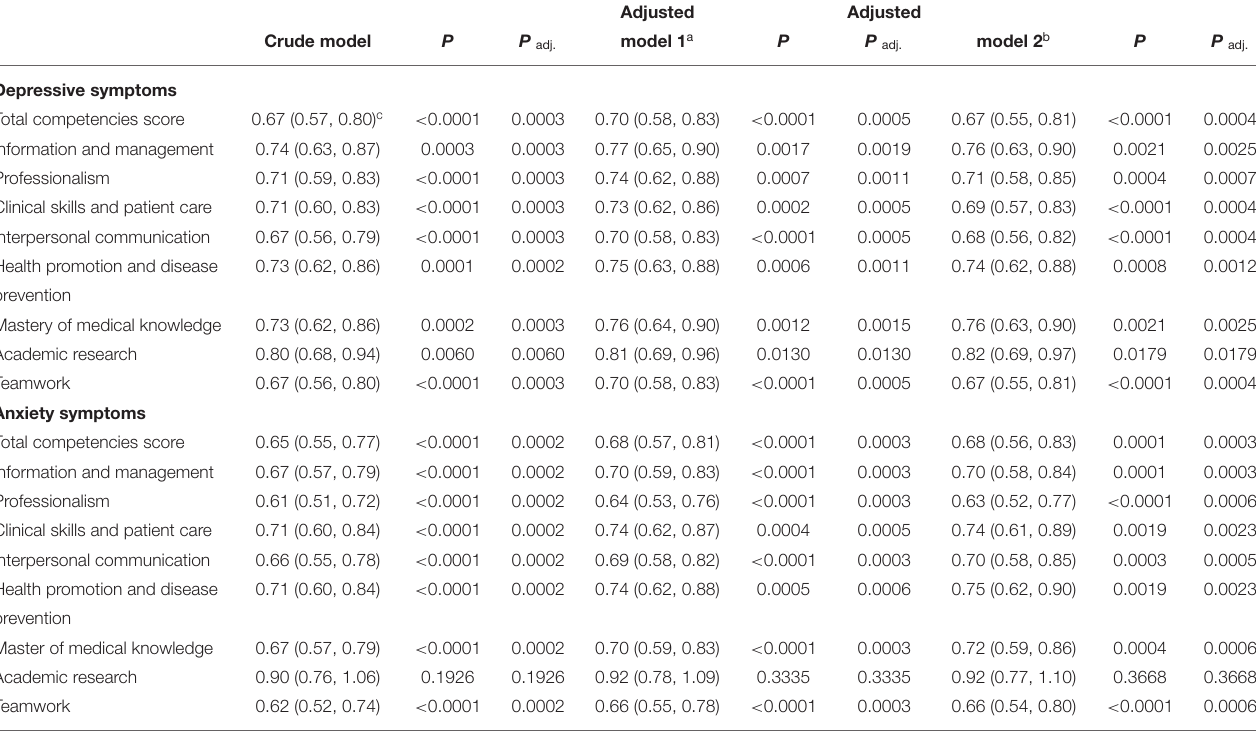
TABLE 3 | Associations between competencies, anxiety, and depressive symptoms among frontline medical staff during the COVID-19 outbreak. Adjusted Adjusted Crude model P P adj. model 1 a P P adj. model 2 b P P